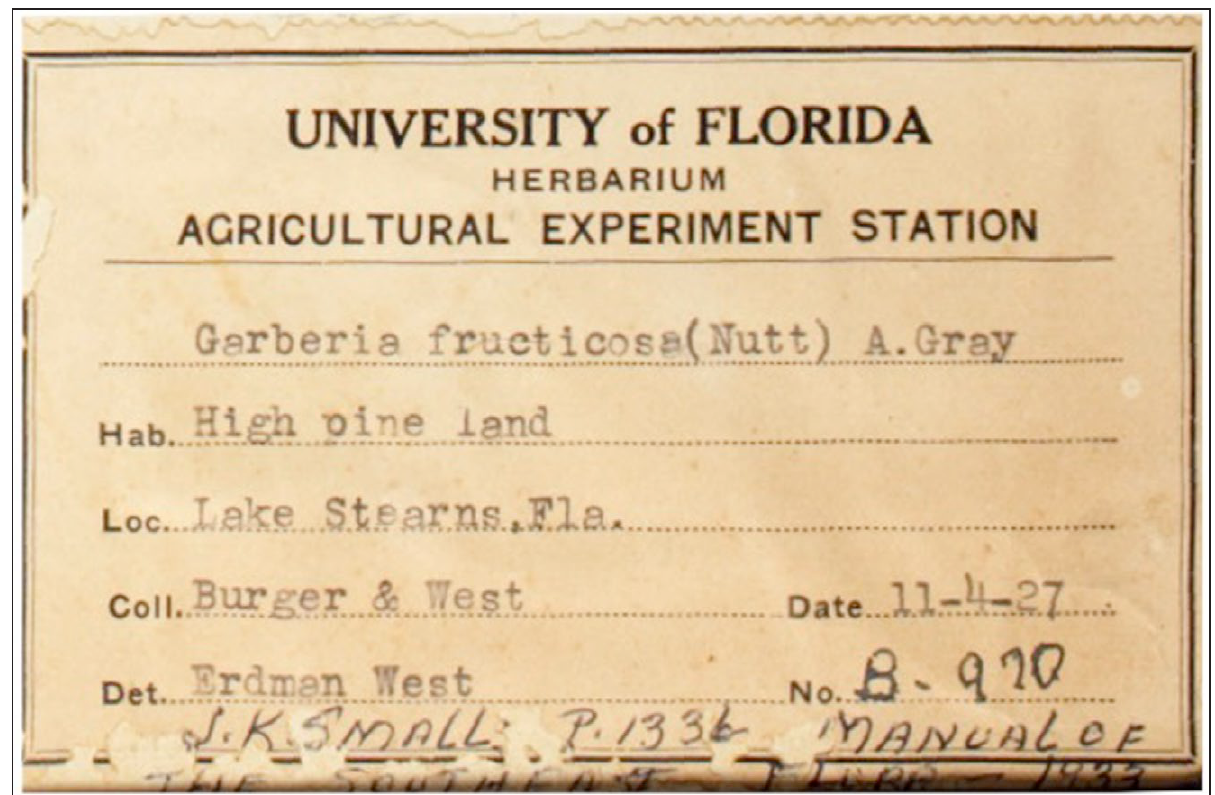
Figure 1: Label from a plant specimen from the Robert K. Godfrey Herbarium, Florida State University, Tallahassee, FL, US, demonstrating the potential challenges of georeferencing collection localities. In this case, the town has changed names since 1927, the locality description is imprecise, and the habitat is likely now residential development. Labels with such characteristics may be especially difficult for citizen science participants to georeference without local